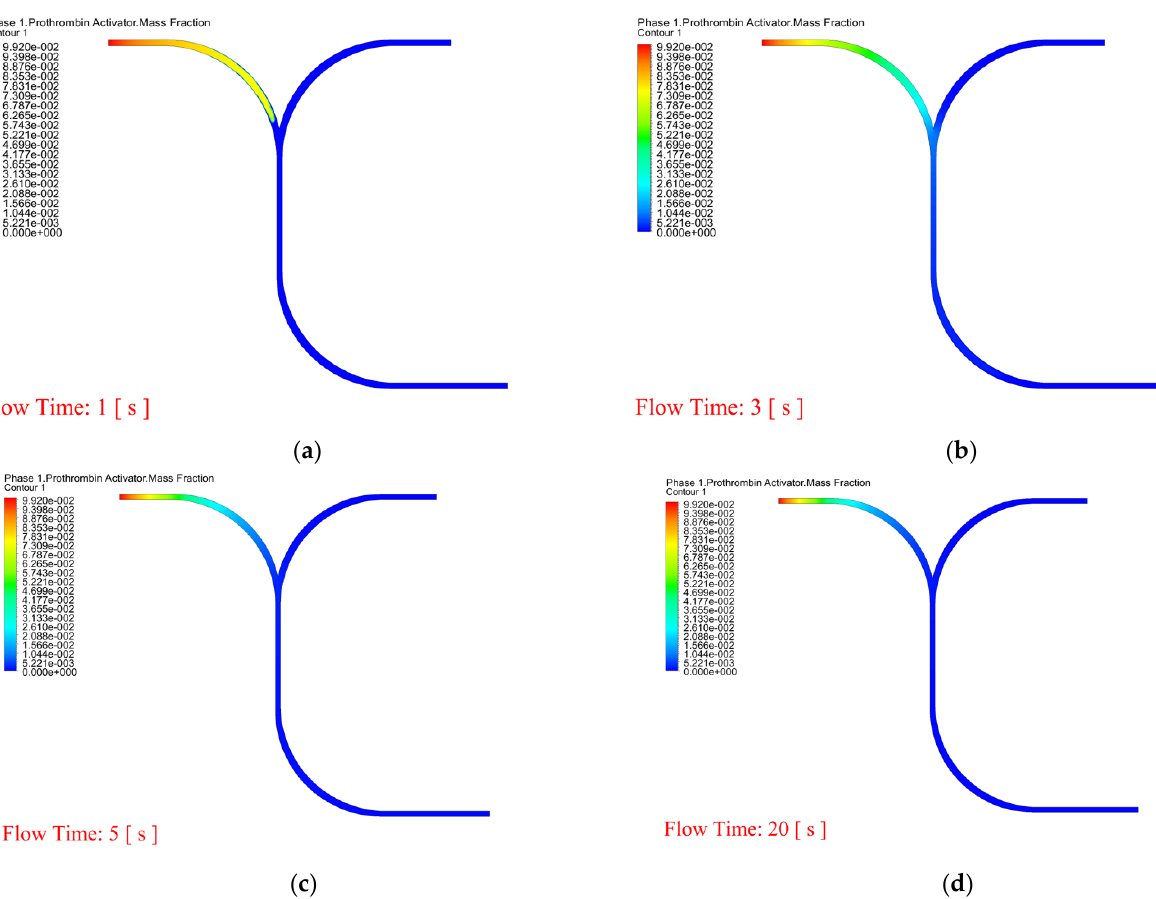
Figure 6. Mass fraction of the prothrombin activator in the microchannel at various times ( a ) 1 s, ( b ) 3 s, ( c ) 5 s, and ( d ) 20 s.